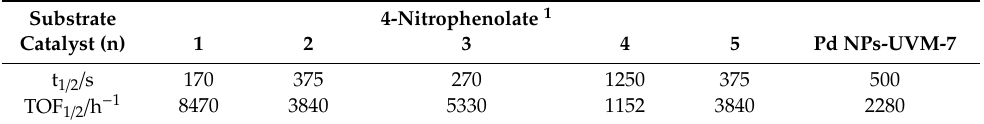
Table 3. Half-life times for the reduction of 4-nitrophenol by (Et 4 N)BH 4 in water at room temperature